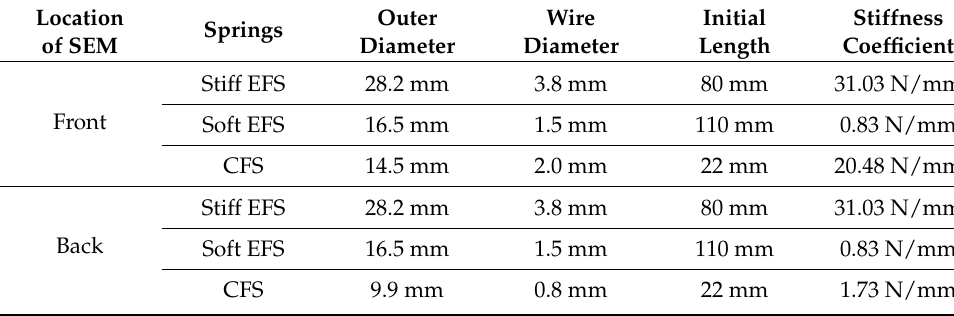
Table 3. Main parameters of the selected springs in the